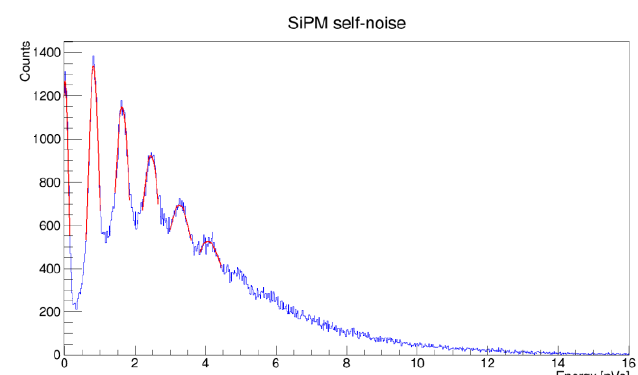
Fig. 8. An example of the photoelectron spectrum of the FC60035 SiPM (blue line) measured at 6 μA and fitted photoelectron peaks (red line). T ABLE I FIT VALUES OF THE PHOTOELECTRON PEAKS Distance Number Error between Mean [nVs] of p.e. [nVs] neighboring p.e.